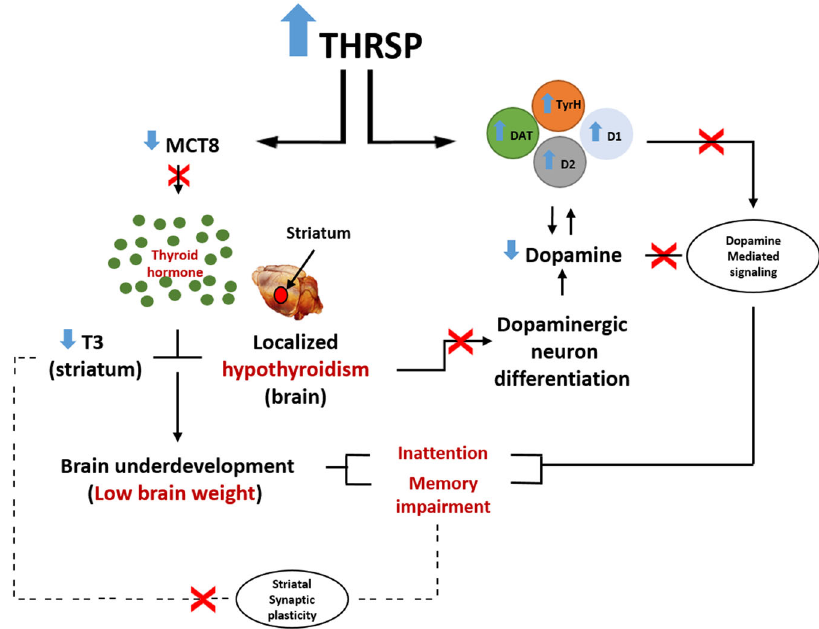
Fig. 11 Scheme for the proposed mechanism underlying THRSP overexpression-induced inattention and memory impairment in mice. Our previous and present fi ndings show that a shared dopaminergic and thyroid hormone mechanism, respectively, is involved in the deranged neurobehavioral patterns observed in THRSP OE mice. THRSP (Thyroid hormone-responsive protein); MCT8 (Monocarboxylate transporter 8); T3 (Triiodothyronine);